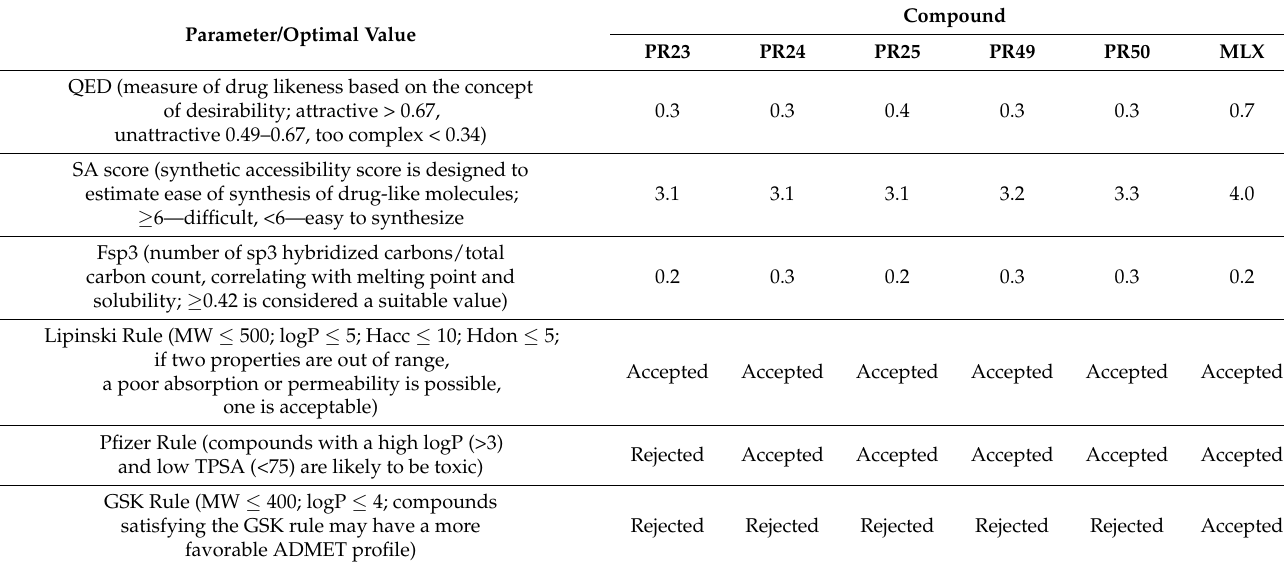
Table 2. Medicinal chemistry parameters of studied compounds and meloxicam